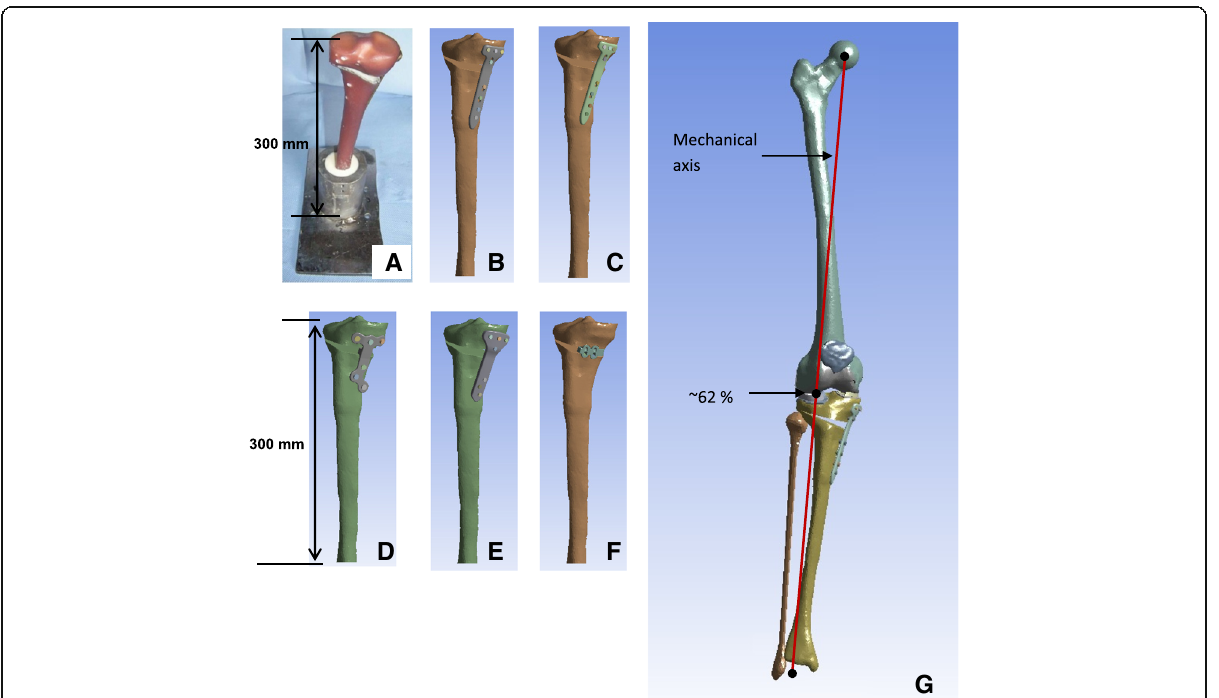
Fig. 1 3D Geometries of models: a Photo of a tested specimen of the experimental study (Diffo Kaze et al. 2015). 3D geometries of the specimen ( b ) TomoFix Std, ( c ) TomoFix sm, ( d ) Contour Lock, ( e ) PEEKPower, ( f ) iBalance. ( g ) 3D geometries of the lower limb model including the osteotomized tibia with the TomoFix std plate. The mechanical axis passed through the Fujisawa point laterally at 62% of the tibia plateau